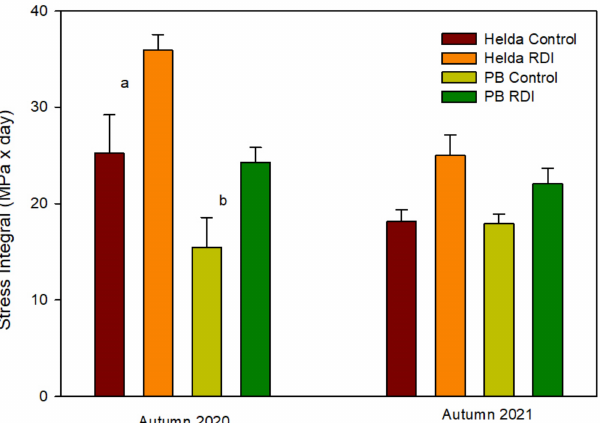
Figure 4. Stress Integral in the 2020 and 2021 seasons. Each bar is the average of four measurements and vertical lines represent the standard error. ‘Helda’ (Control, brown and RDI, orange) and ‘Perfecci ó n Blanca’ (Control, light green and RDI, dark green). Different letters indicate significant differences between